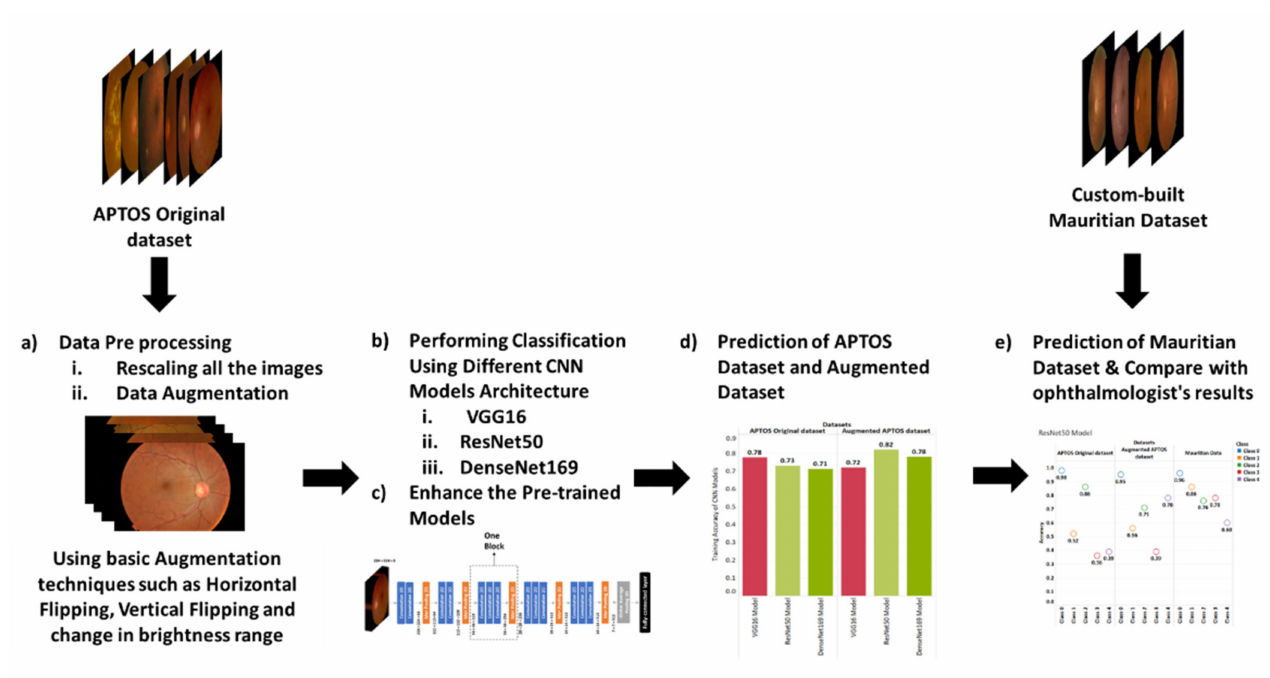
Figure 1. Workflow of our proposed